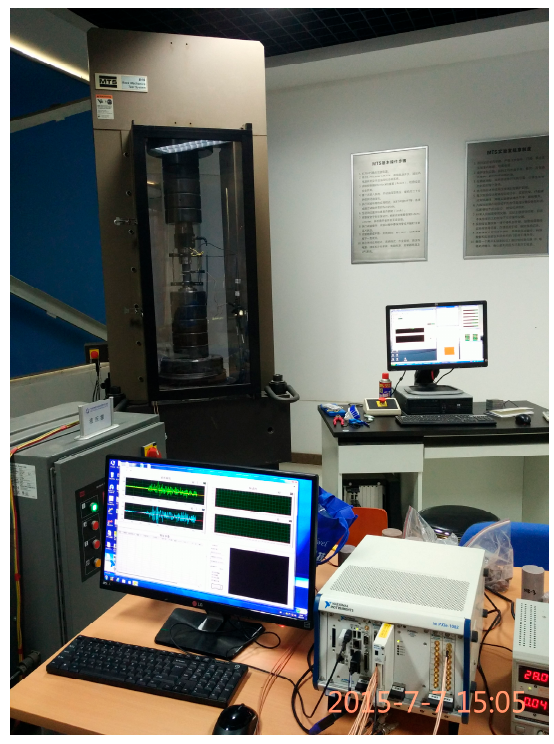
Figure 3. MTS 815 servo-controlled hydraulic testing machine for the laboratory tests.